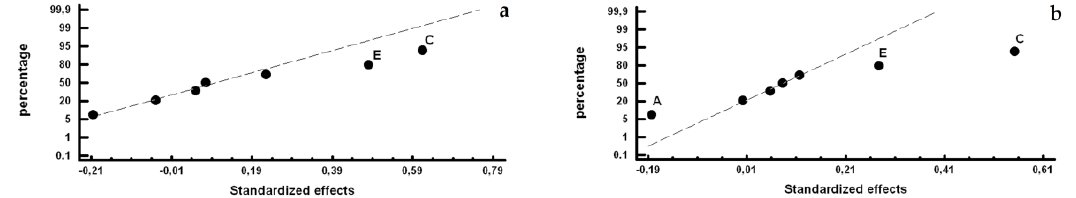
Figure 5. Representation of the standardized effects on a normal probability plot versus the unnotched Charpy test: ( a ) Region I and ( b ) Region II.